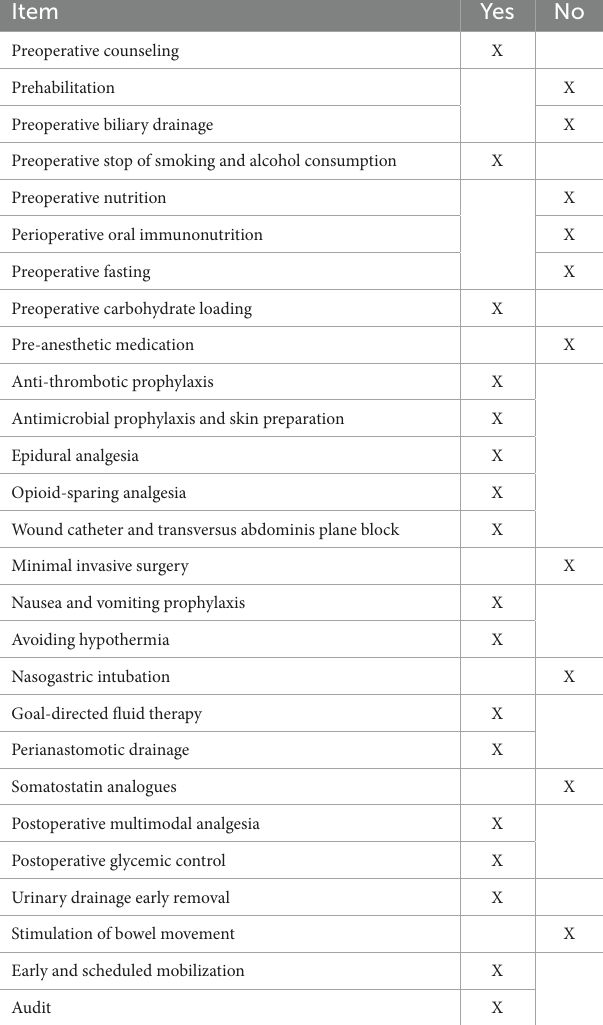
TABLE 1 ERAS items implemented in both